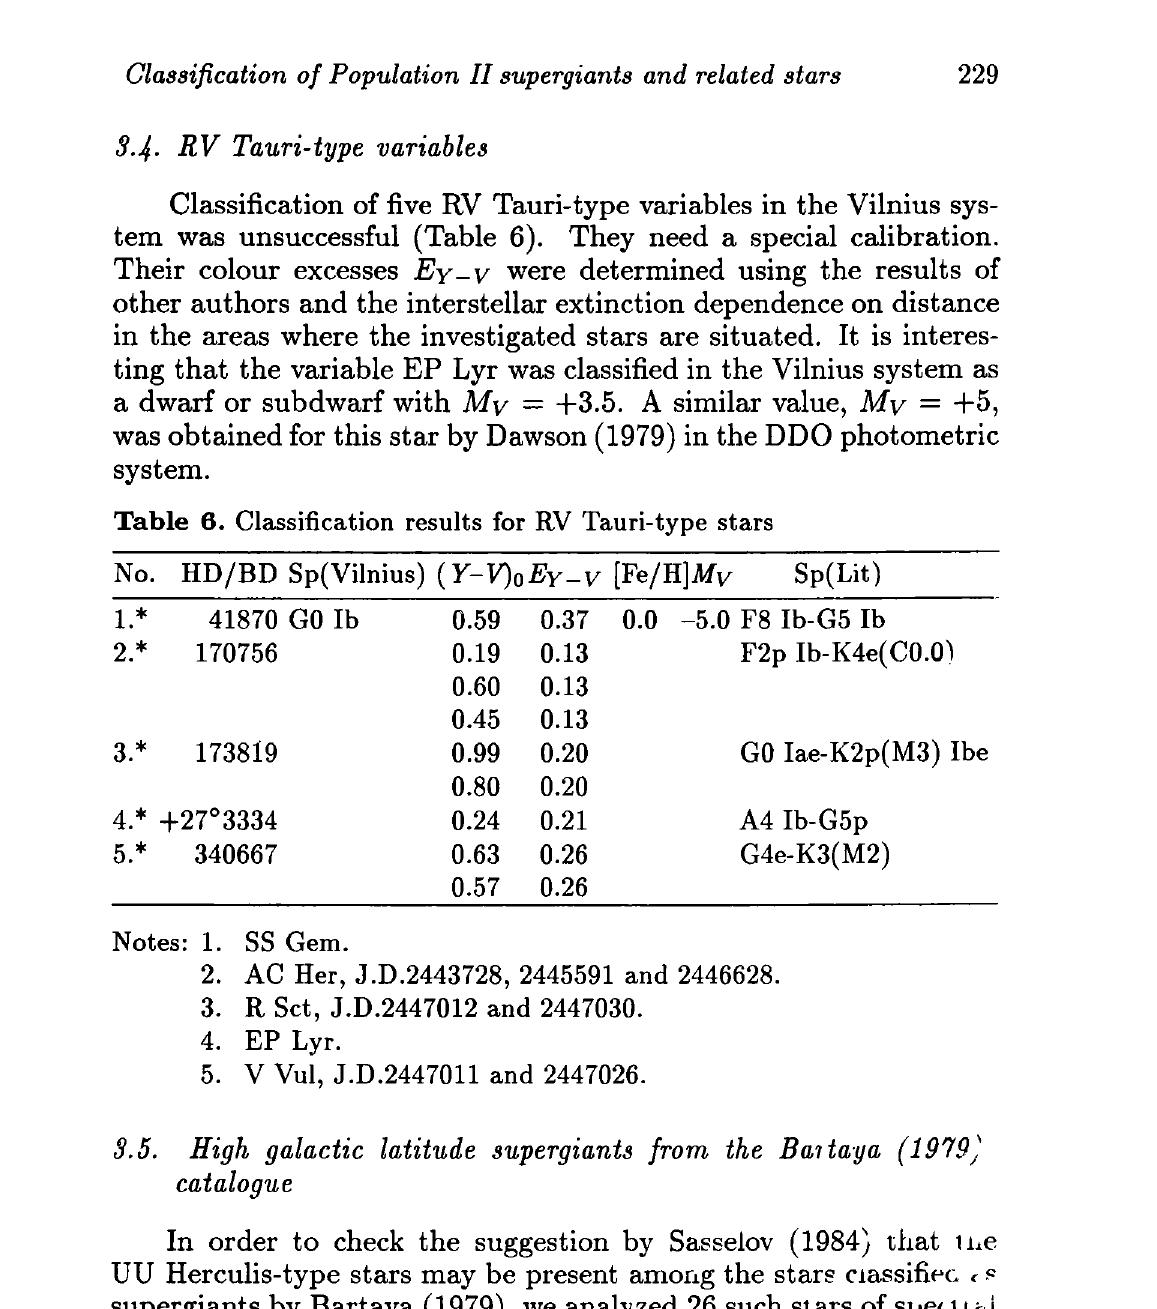
Table 6. Classification results for RV Tauri-type stars